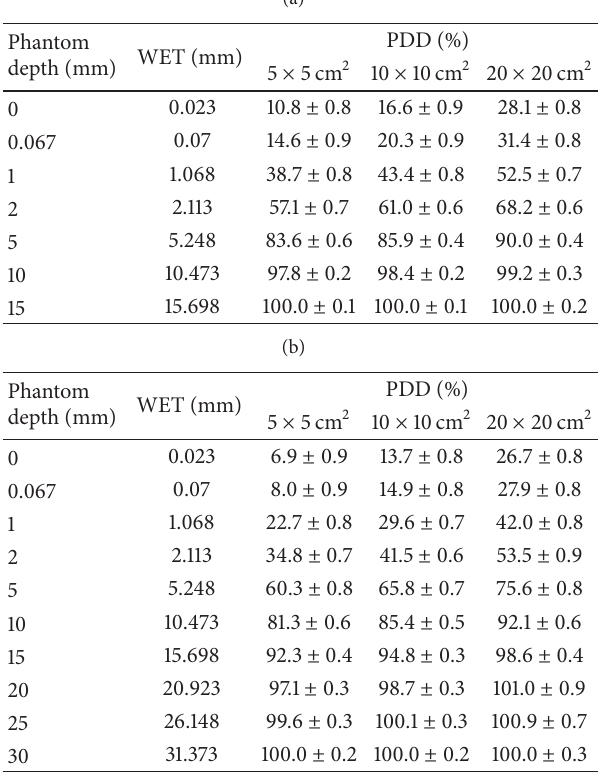
Table 1: (a) Percentage depth doses (PDDs) obtained with a Markus chamber in a water equivalent RW3 phantom using 6MV photon beams for different field sizes at SSD = 100cm. (b) Percentage depth doses(PDDs)obtainedwithaMarkuschamberinawaterequivalent RW3 phantom using 15 MV photon beams for different field sizes at SSD = 100